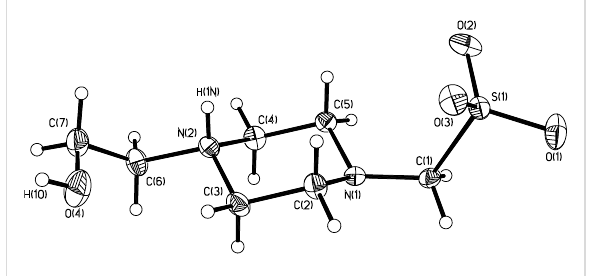
Figure 4: Crystal structure of HEPMS 2 with displacement ellipsoids at the 30% probability